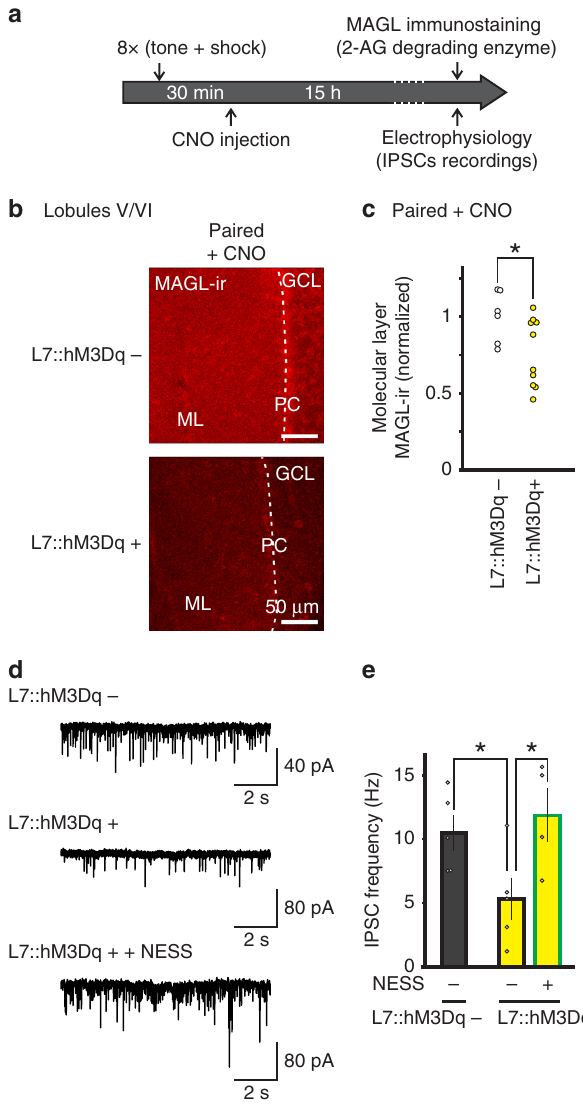
Fig. 10 Activation of Gq pathways in Purkinje cells after learning reduces MAGL expression in the cerebellum and blocks the learning-induced increase in GABA release. a Experimental protocol. Animals were subject to fear conditioning on day 1 and administered with CNO 30 min later, and immunostaining of MAGL and sIPSC recordings were performed 15 h after learning. b Typical MAGL immuno fl uorescence images obtained from L7::hM3Dq + and L7::hM3Dq − mice (see below for the number of independent replications). c Group data showing a lower MAGL immunoreactivity in L7::hM3Dq + ( n = 10 animals with measurement in at least two different slices each) compared to L7::hM3Dq − mice ( n = 6 animals with measurement in at least two different slices each, two-sided paired t -test, P = 0.044). d Representative traces of spontaneous IPSCs recorded in stellate cells from L7::hM3Dq − (top) and L7::hM3Dq + (middle and bottom). e Group data showing that sIPSC frequency in stellate cells from L7::hM3Dq + mice ( n = 5 cells) is lower than in stellate cells from L7::hM3Dq − mice ( n = 5 cells, two-sided unpaired t -test, P = 0.044) and increased during application of the CB1 receptor antagonist NESS 0327 ( n = 4 cells, two-sided unpaired t -test, P = 0.041). Data in e are presented as mean values ± SEM. Statistical analysis and P values can be found in Supplementary Table 4 and original data in the Source Data fi